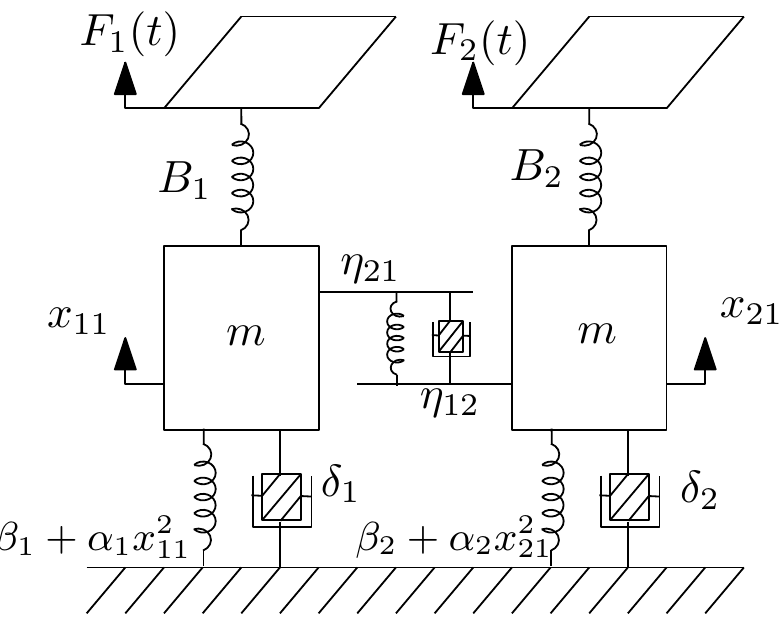
Figure 2. Free body scheme representation of two interconnected mechanical oscillators. In this example, δ i = 0.5, β i = − 1, α i = 1, and the interconnection parameter η i = 0.5. To obtain the local linear representation, we used one-step time-series data with 10 5 ran- dom initial conditions uniformly distributed in the domain [ − 0.8, 0.8 ] × [ − 0.8, 0.8 ] with sample time T s = 0.01. The input matrix was approximated using 10 4 random inputs over the interval [ − 1, 1 ] . Notice that each subsystem required neighborhood state measure- ments to identify the coupling dynamics. The radial basis function centers were uniformly distributed in the domain. To evaluate the performance of the interconnected model, we compared the uncontrolled system states using an input u i = 0.5 cos ( t ) . The compari- son between the linear representation and the original system for the initial condition x 0 = [ 0.31, − 0.34, − 0.33, 0.31 ] is shown in Figure 3. It is apparent that including the cou- pling term in the model improved the prediction capacity. The objective of the control problem was to stabilize the system in the origin. The cost function weights were chosen as Q = I , H p = 50, and R = 0.01, and the input constraint was − 1 ≤ u ≤ 1 for the two subsystems. The closed-loop local phase-plane and input signals are presented in Figure